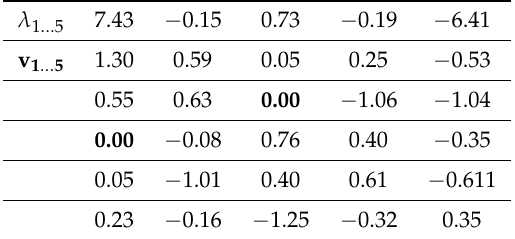
Table 7. Difference in element values for the fluid leakage fault